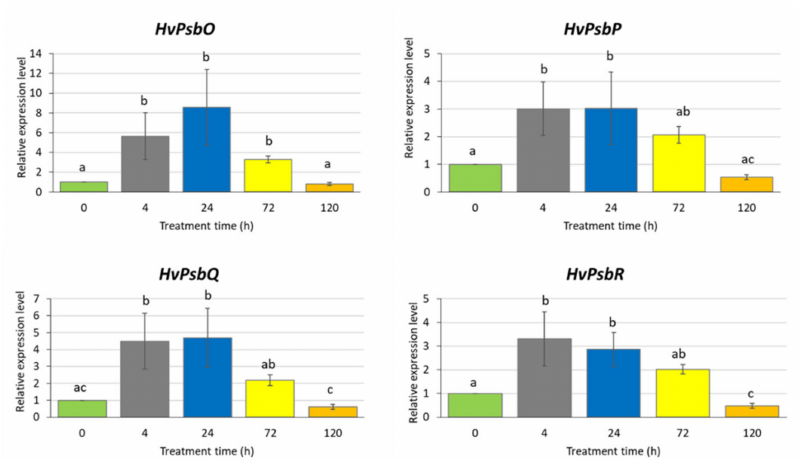
Figure 3. Expression of the genes encoding extrinsic proteins of Oxygen-Evolving Complex in leaves of barley seedlings treated with 500 µ M methyl jasmonate. The relative expression level was assessed in relation to control plants grown without MeJA solution. The statistical analysis was performed using a one-way ANOVA followed by the Fisher Least Significant Di ff erence (LSD). Statistically significant di ff erences ( p < 0.05) are indicated by di ff erent letters.